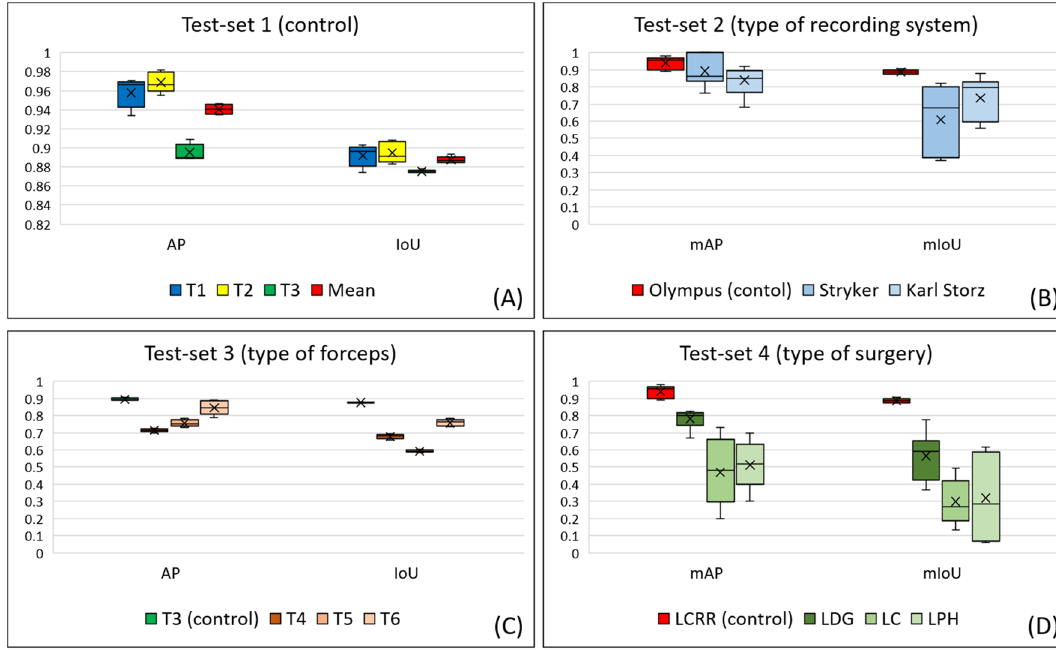
Figure 2. Surgical-instrument recognition-accuracy results ( AP average precision, IoU intersection over union, mAP mean average precision, mIoU mean intersection over union). ( A ) AP and IoU under the same condition as the training set (T1: harmonic shears; T2: endoscopic surgical electrocautery; T3: Aesculap AdTec atraumatic universal forceps). ( B ) mAP and mIoU for different types of laparoscopic recording systems. ( C ) AP and IoU for different types of laparoscopic surgical forceps (T3: Aesculap AdTec atraumatic universal forceps; T4: Maryland; T5: Croce-Olmi; T6: needle holder). ( D ) mAP and mIoU for different types of surgery ( LCRR laparoscopic colorectal resection, LDG laparoscopic distal gastrectomy, LC laparoscopic cholecystectomy, LPH laparoscopic partial hepatectomy).